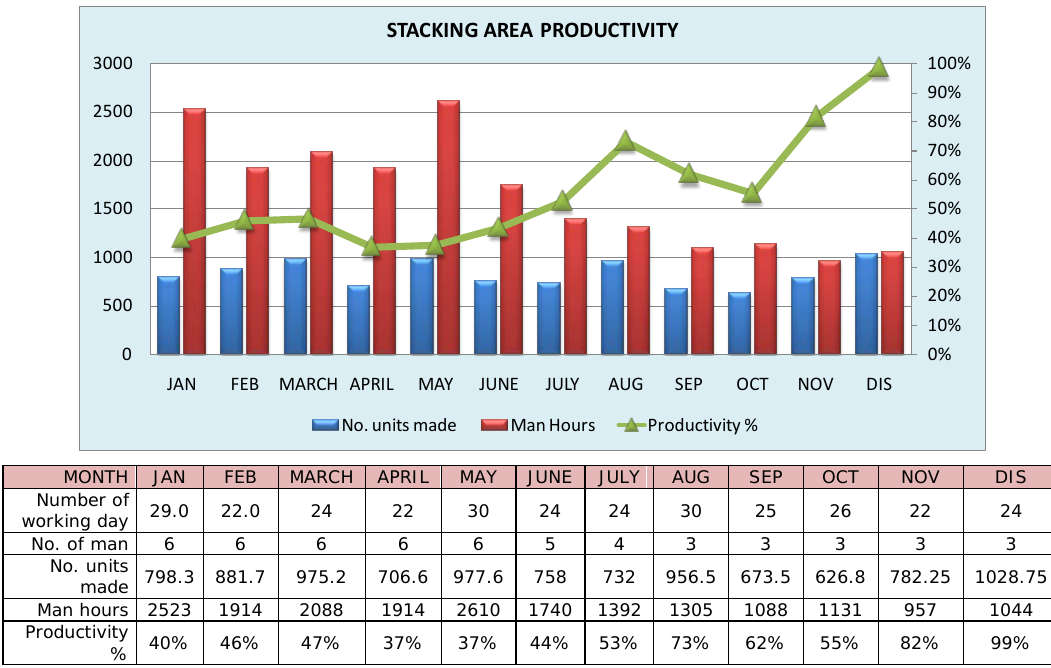
Figure 16. “Relationship between time and units produced (People